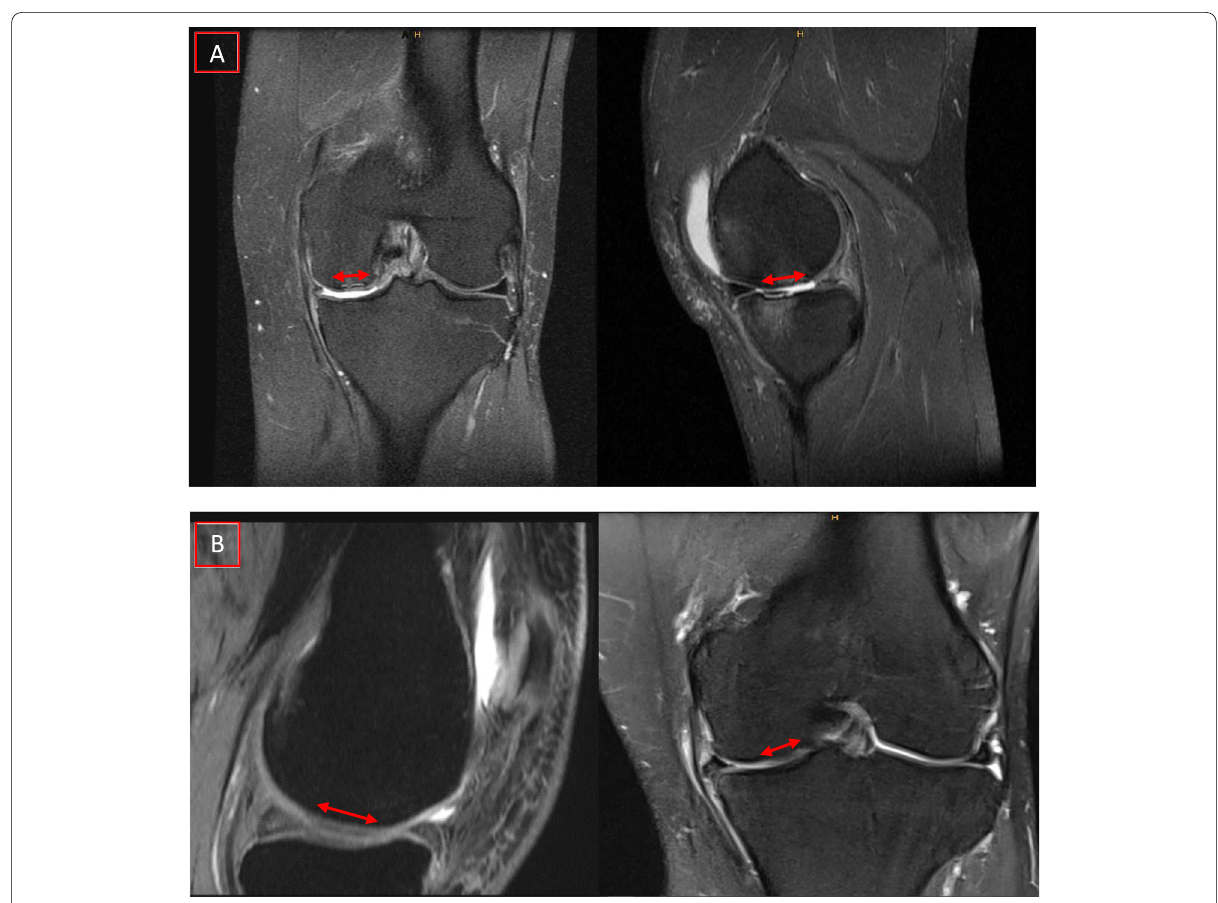
Fig. 1 Examples of cartilage defect assessment on MRI and grading according to the AMADEUS instruction guide. A ) Example of a full thickness cartilage defect with an associated bone marrow edema and small (< 5 mm bony defect) scoring for an AMADEUS grade IV. B ) Example of a superficial cartilage defect with intact subchondral bone and absent bone marrow edema scoring for an AMADEUS grade